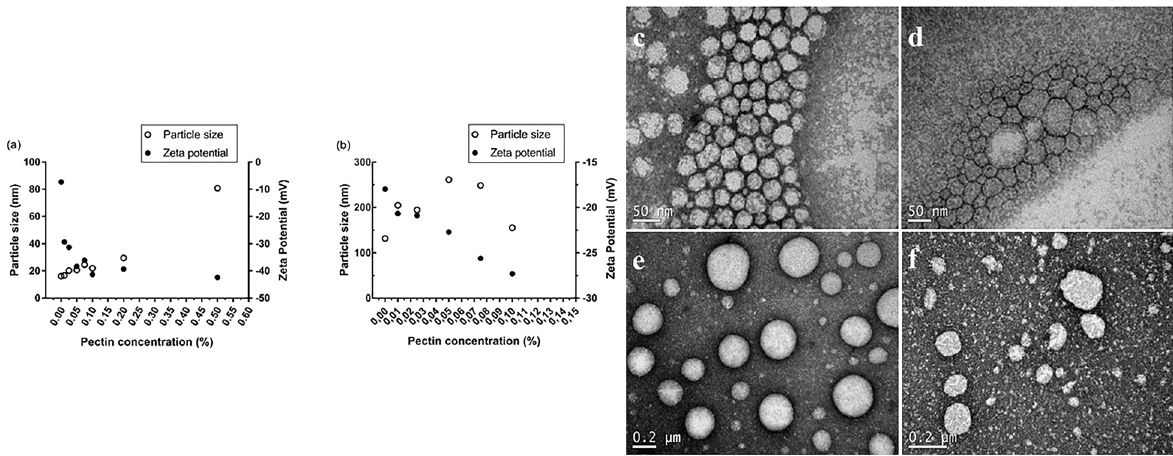
Figure 2. Particle size and zeta potential of the nanoparticles prepared with Tween 80 (a) and Tween 20 (b) according to the concentrations of pectin. Transmission electron microscopy of BC PC T80-NP (c) and BC PC T20-NP (e) with pectin and BC T80-NP (d) and BC T20-NP (f) without